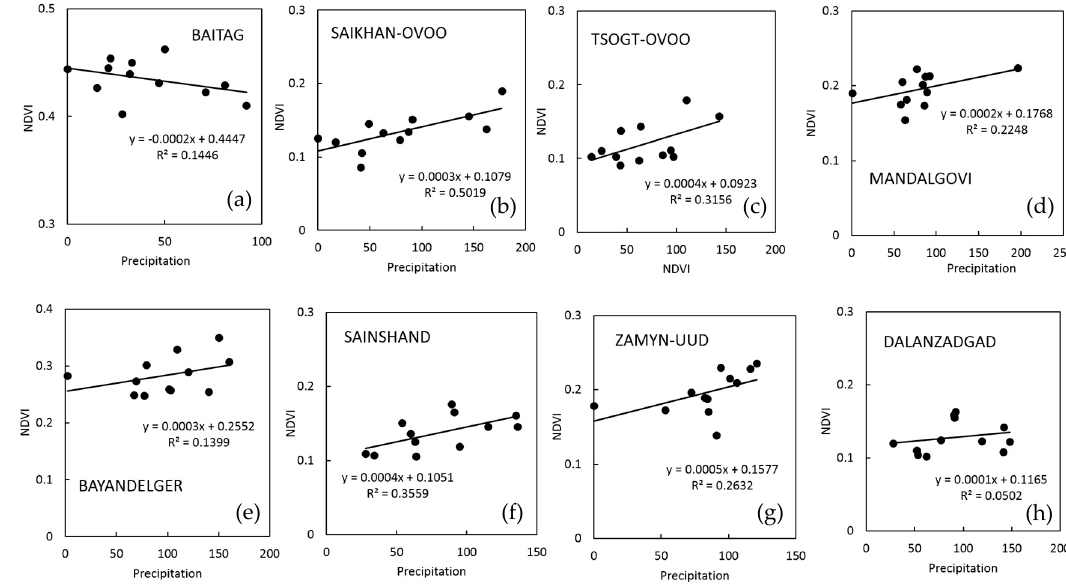
Figure 9. ( a – h ) Relationship between NDVI and precipitation at each station.